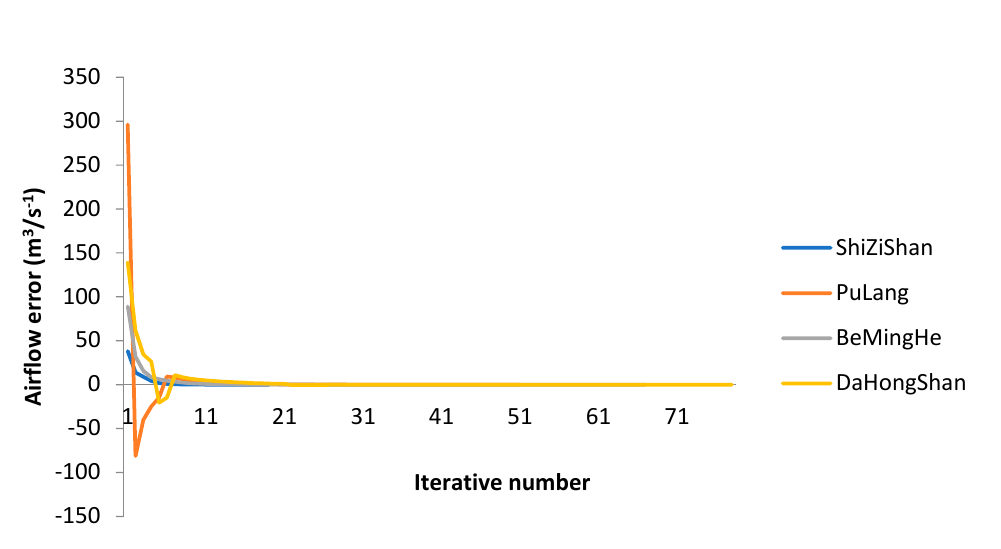
Table 2. Comparison of the iterative number for ventilation networks with different branches using the traditional Hardy Cross solution method with the improved closed loop solution method.